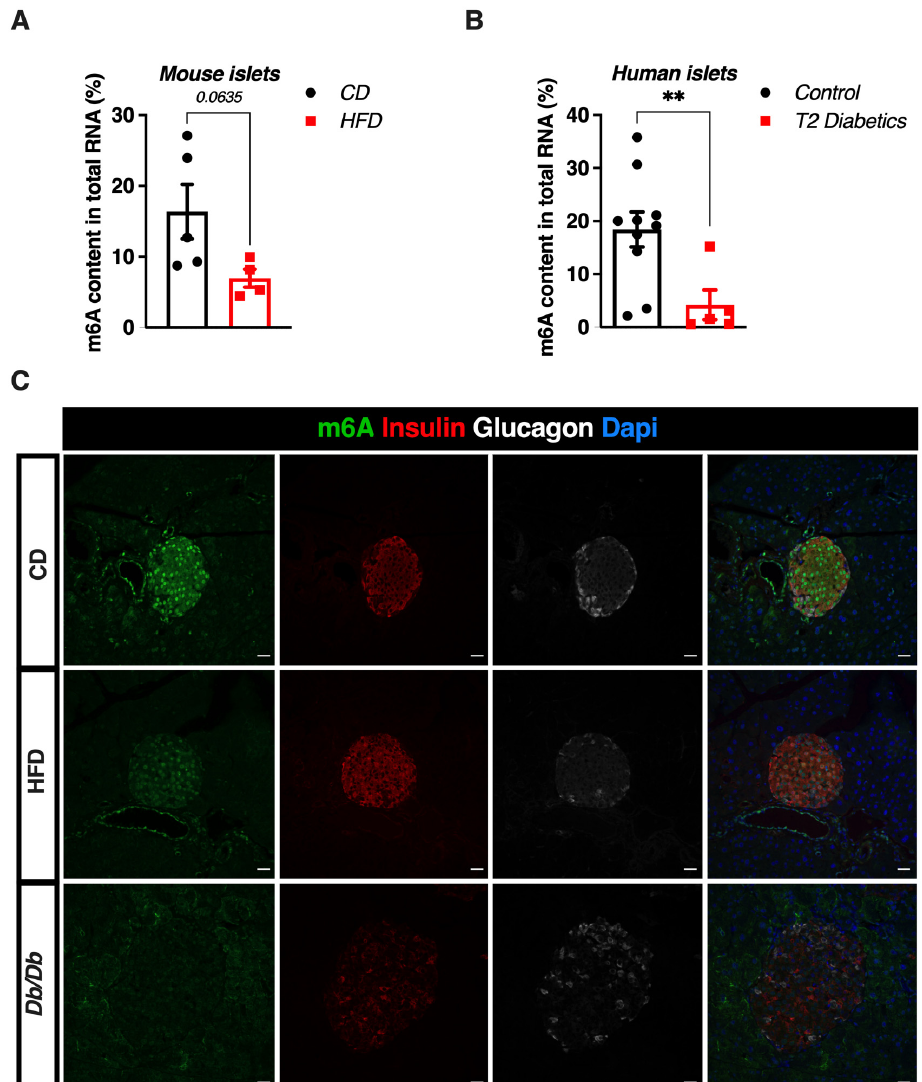
Figure 1. m 6 A RNA methylation in human and murine diabetic islets. ( A , B ) ELISA quantification of m 6 A levels in total RNA from ( A ) pancreatic islets isolated from mice fed with chow diet ( n = 5) or high fat diet during 12 weeks ( n = 4) and ( B ) human control islets ( n = 10) vs. human islets from donors with T2D ( n = 5). Data were analyzed by Mann–Whitney test. ** p < 0.01. ( C ) Representative immunofluorescent staining of m 6 A levels (in green), insulin (in red) and glucagon (in white) in pancreatic sections from 15-week-old wild C57Bl6J mice fed with chow (CD), high fat (HFD) diets or from 15-week-old db/db mice. Nuclei were stained with Dapi (in blue). Scale bar represents 22 µ